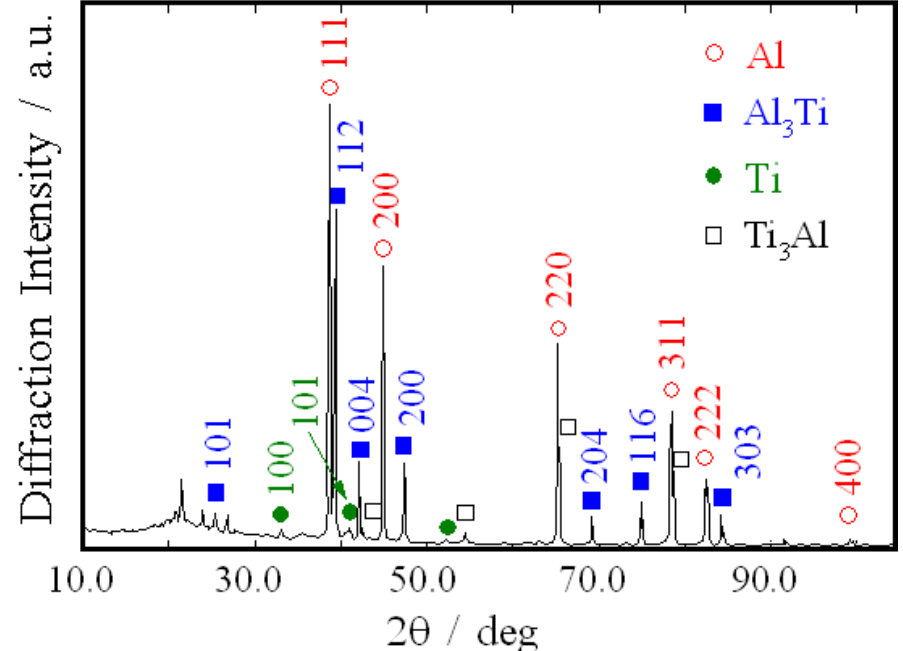
Figure 12. X-ray diffraction pattern of the sample processed at 1350 °C shown in Figure 11